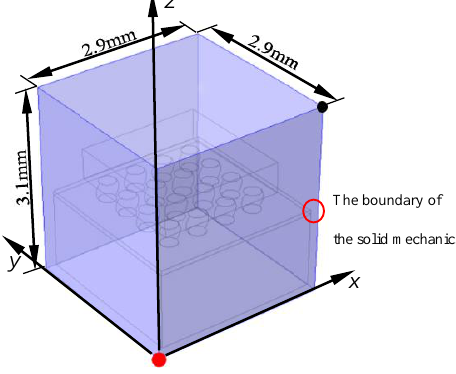
Figure 4. Power density of the cyclic thermal load.